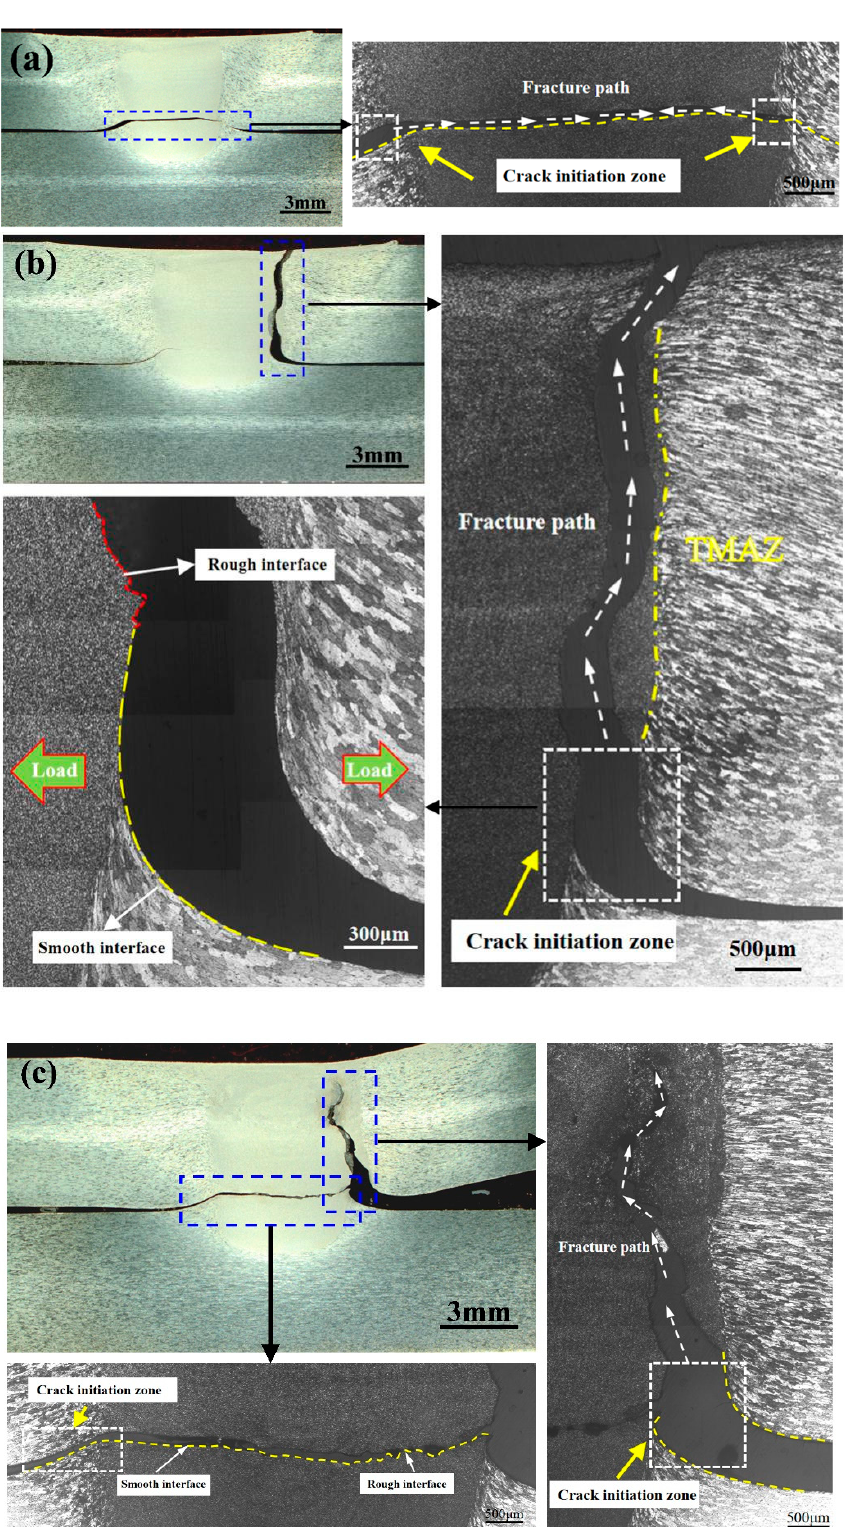
11 of 18 Figure 12. Fracture positions of FSLW and UAFSLW joints: ( a ) FSLW and UAFSLW welded by tool T1, ( b ) FSLW and UAFSLW welded by tool T2, and ( c ) FSLW and UAFSLW welded by tool T3. Figure 13 shows the characteristic fracture behaviour of the FSLW joints, and three fracture modes occur during lap shear tests. Fracture mode I is a shear fracture where the failure occurs along the original interface of the whole joint. For both configurations A and B, only shear-fracture mode occurs for the FSLW and UAFSLW joints when using tool T1. Shear fracture also occurs for the FSLW and UAFSLW joints fabricated with tools T2 and T3 in configuration A (Figure 13a). Fracture mode II is a tensile fracture where the crack initiates at the tip of the hook defect on the AS, and the end of the fracture path is nearly normal to the tensile direction. This fracture mode occurs in the FSLW and UAFSLW joints fabricated by tool T2 in configuration B (Figure 13b). The fracture path propagates up the SZ or TMAZ interface until tensile fracture occurs. Although the metal around the hook defect is severely deformed, the interface hook hinders the mixing of the metals on both sides, so the interface remains very smooth after the fracture, and the rough interface of the SZ and TMAZ exhibits typical tensile-fracture characteristics. Fracture mode III is a mix of shear fracture and tensile-fracture